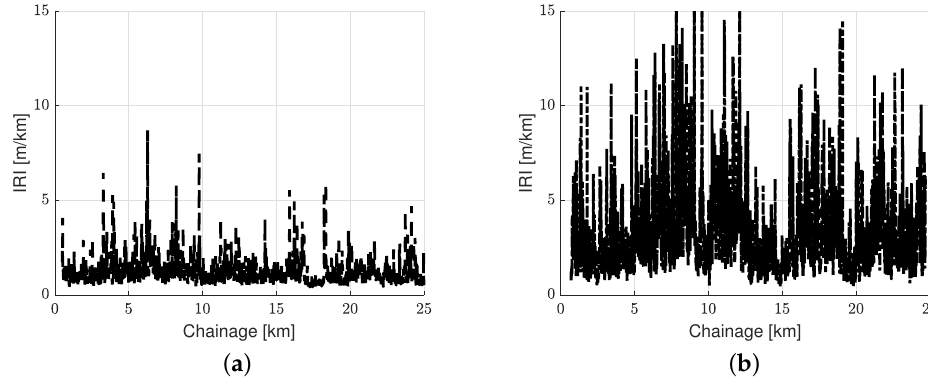
Figure 5. Overview of standard road condition data utilized in the experimental investigation: ( a ) measured IRI (black line) for highway road M3 in the southbound direction and ( b ) measured IRI for urban road